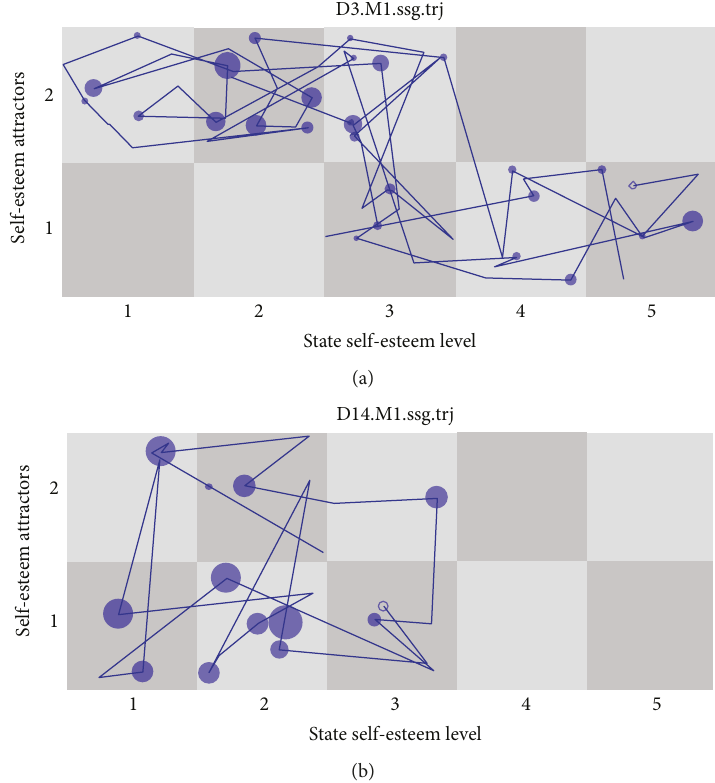
Figure 8: Two examples of state space grids from our data portraying the time series for self-esteem attractor expression ( y -axis) against the time series for state self-esteem ( x -axis). The lines indicate direction of movement between events, and circles indicate duration of events. (a) Illustrates an individual with a high level of self-esteem attractor constraint, while (b) illustrates an individual with a low level of self-esteem attractor